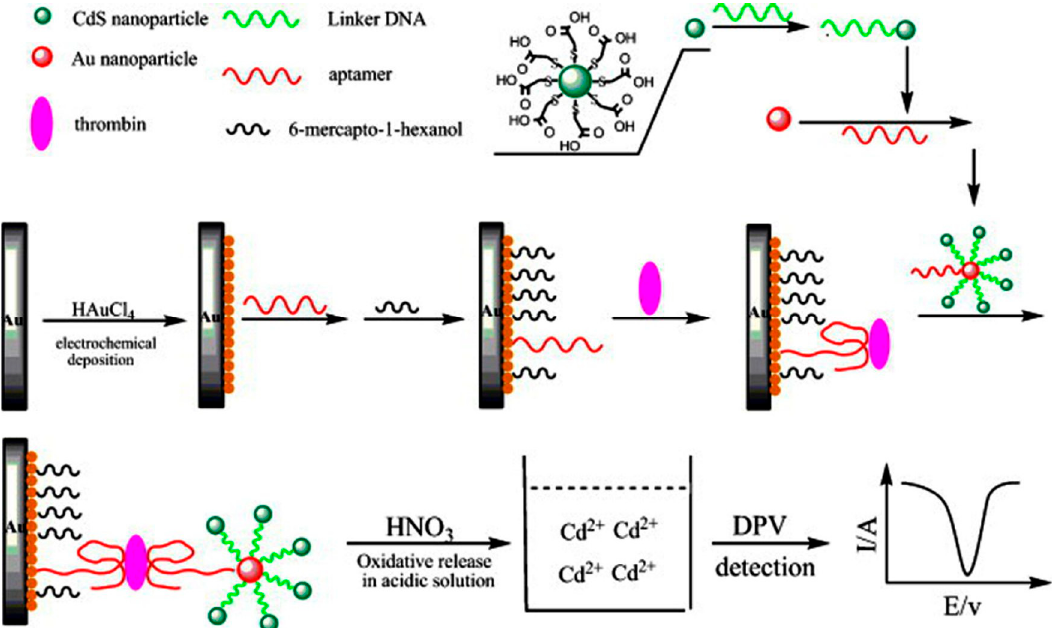
Figure 1. Scheme of an electrochemical method for the determination of thrombin based on aptamers forming a sandwich structure on an Au electrode covered by electrodeposited Au nanoparticles. The dissolution of CdS nanoparticles linked around gold nanoparticle labels releases Cd 2+ ions that are detected by differential pulse voltammetry. Reprinted with permission from reference [46]. Copyright 2010 Elsevier.